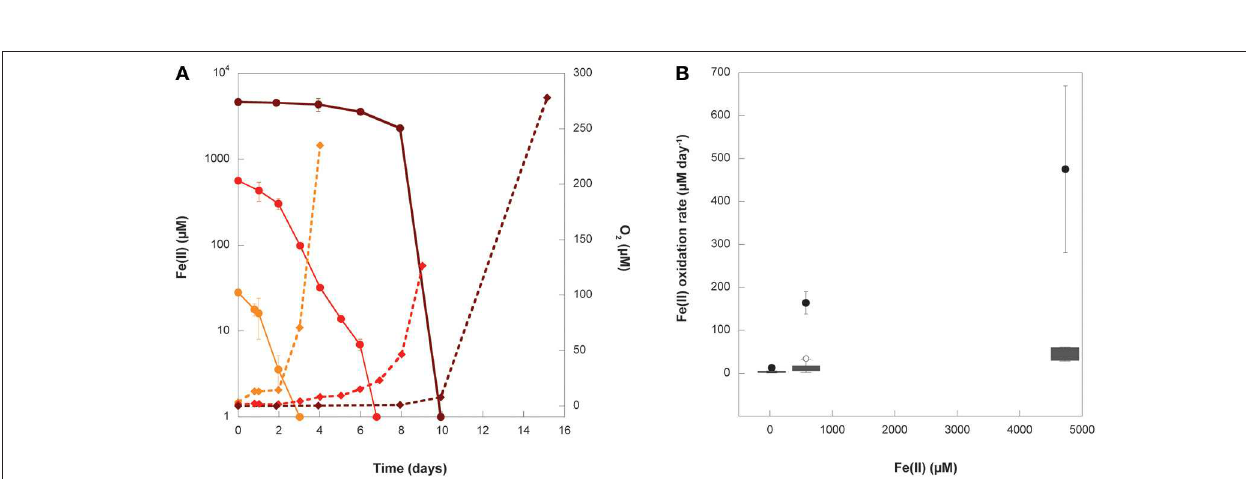
FIGURE 6 | (A) Fe(II) (circles) and O 2 (diamonds) measurements from representative replicates of experiments where Synechococcus PCC 7002 was grown under conditions that began anoxic with either 29 µ M (orange), 577 µ M (red), or 4732 µ M (dark red) initial Fe(II). Error bars represent the standard deviation on replicated Fe(II) analyses from a single experiment. Error bars for O 2 are smaller than the symbols. (B) The Fe(II) oxidation rate calculated from linear regression (black circles) of data in (A) and the median, upper, and lower quartiles (gray boxes), range (whiskers), and outliers (open circles) of all oxidation rates calculated using Equation (1) for instantaneous measurements of Fe(II) and O 2 concentrations in (A) for each initial Fe(II) concentration.